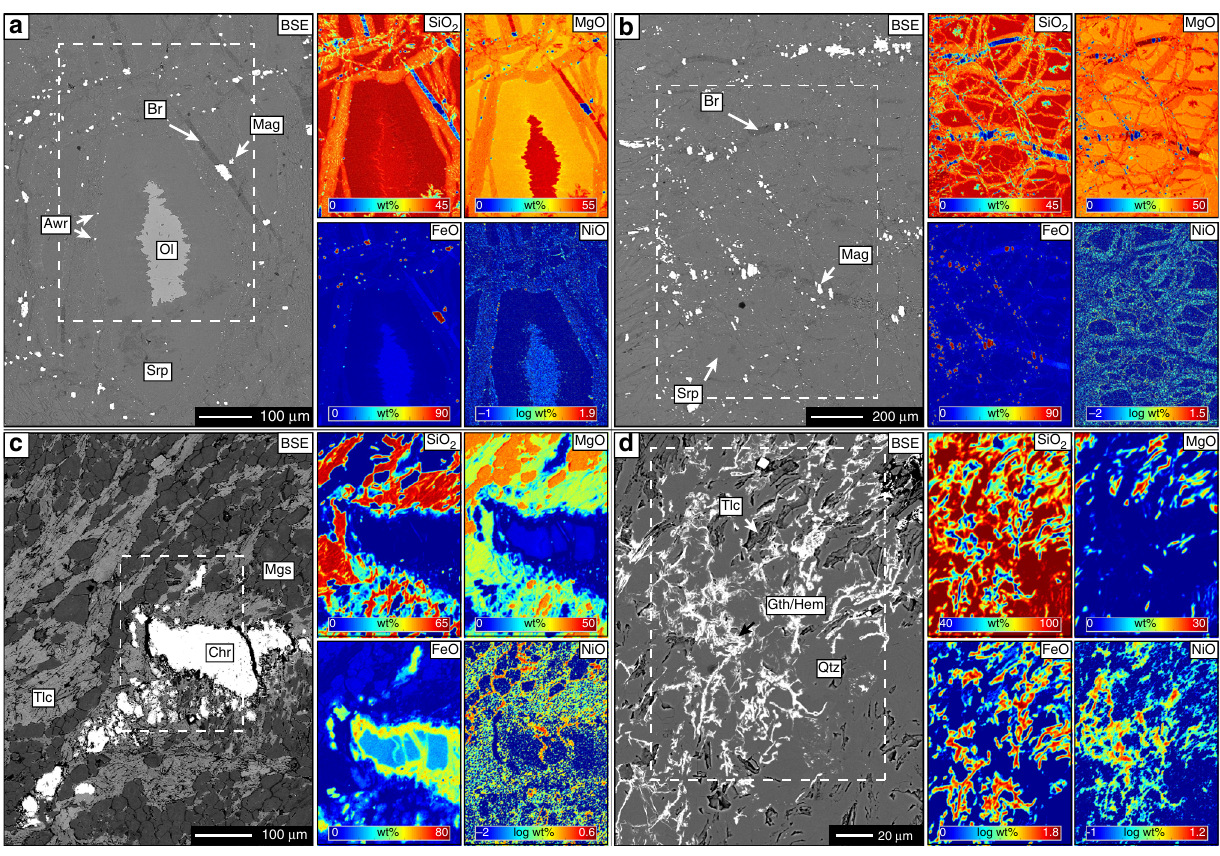
Fig. 2 Textural and chemical changes during ultrama fi c rock alteration. Back-scattered electron (BSE) images and element distribution maps of a serpentinised peridotite, b serpentinite, c talc-carbonate altered serpentinite, and d laterite show that the reaction sequence is accompanied by progressive partitioning of Si and Ni into weathering resistant phases. a , b show samples from the Feragen Ultrama fi c Body (Norway), c , d show samples from the Six Mile Well-Goliath Complex, SGC (Australia). For the discussion of different alteration environments we distinguish between weathering that happens exclusively at the surface (e.g. laterite formation) and hydrothermal alteration (e.g. serpentinisation, carbonation) at depth and at higher temperature. Awr = awaruite, Br = brucite, Chr = chromite, Gth = goethite, Hem = hematite, Mag = magnetite, Mgs = magnesite, Ol = olivine, Qtz = quartz, Srp = serpentine, Tlc = talc